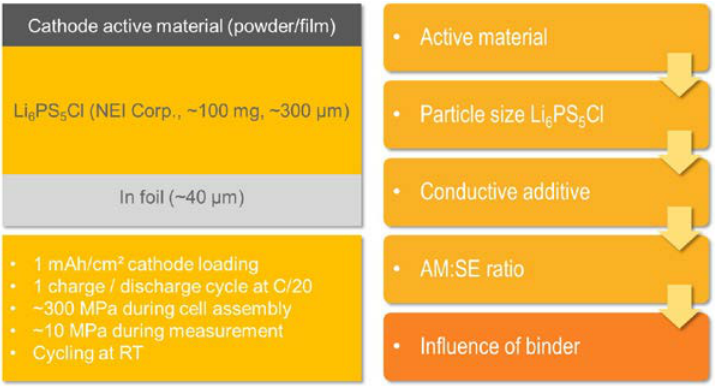
Figure 1. Schematic outline of the composite cathode optimization by dry- and wet-chemical processing. In addition, the testing conditions are listed.